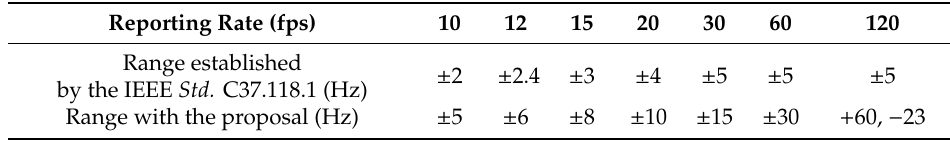
Table 3. Frequency deviation ranges for the steady-state test.